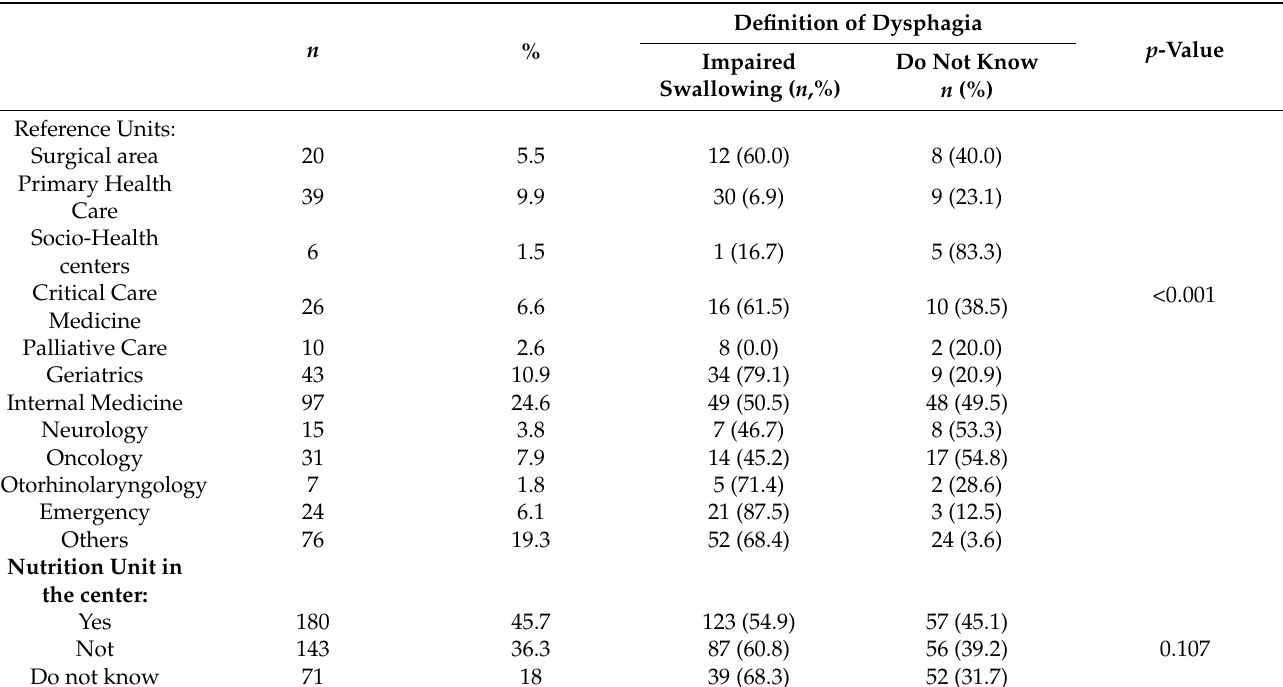
Table 1. Work units and presence of Nutrition Units.